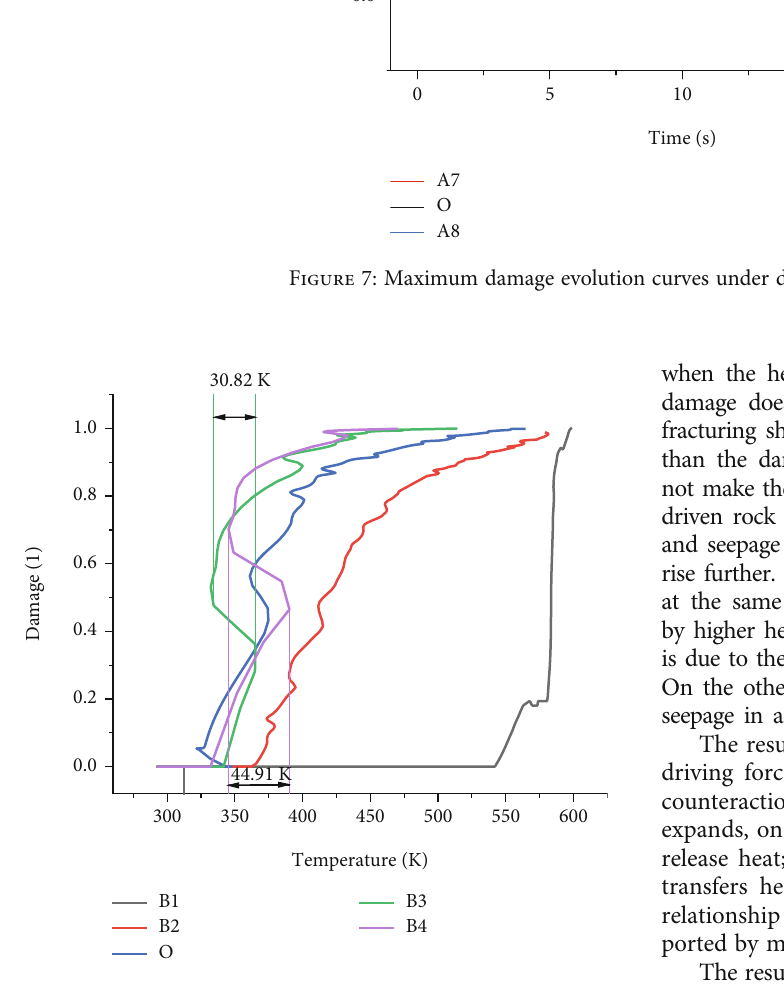
Figure 8: T - d curve of the heat source center point under di ff erent heat source